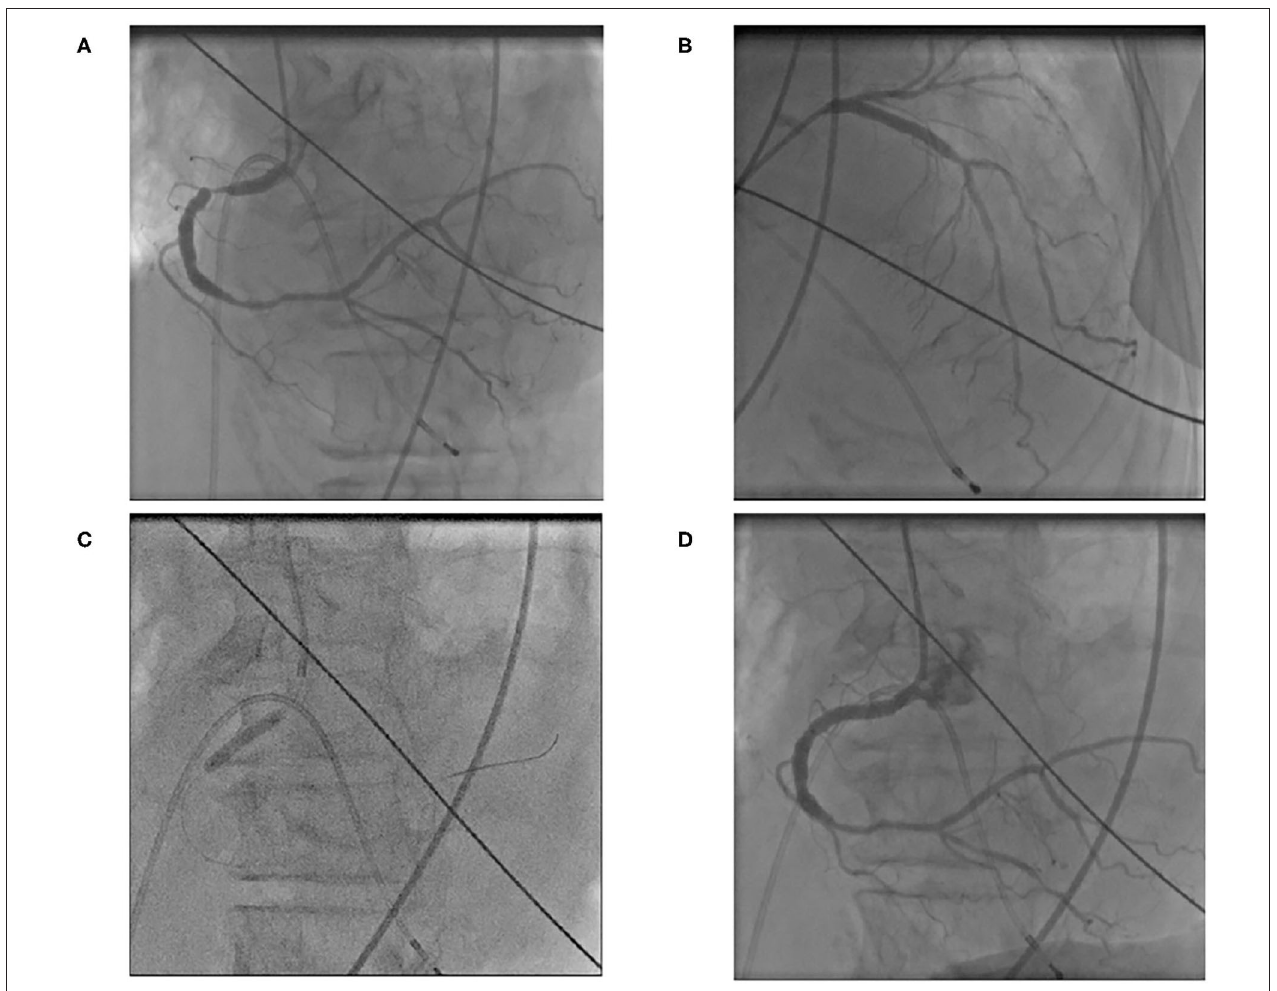
FIGURE 3 | Right coronary angiogram showed severe (99%) stenotic lesion in segment 1 (A) . Collateral circulation from left anterior descending artery was visualized (B) . Stent implantation was performed (C) and right coronary angioplasty was completed (D)